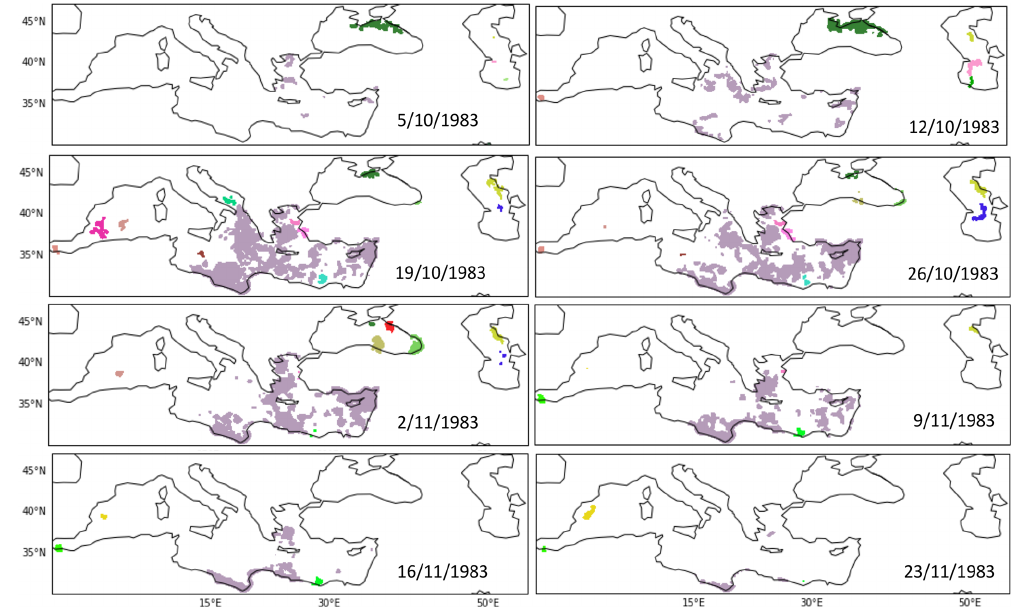
Figure 7. MHW macroevents and their evolution in time, from 5 October 1983 to 23 November 1983, over the Mediterranean Sea, as detected by the connected component